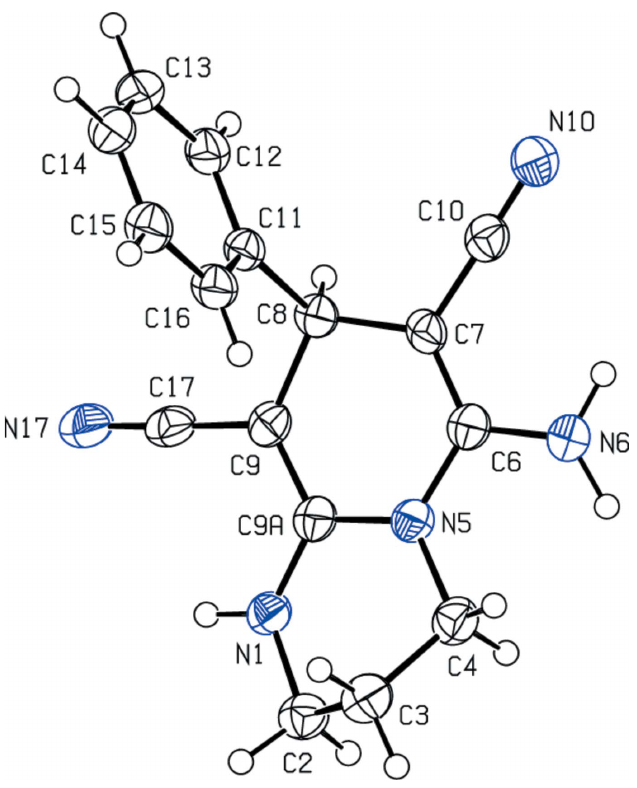
Figure 3 View down [100] showing the formation of (001) layers in the title compound by means of N—H (cid:2)(cid:2)(cid:2) N, C—H (cid:2)(cid:2)(cid:2) N, C—H (cid:2)(cid:2)(cid:2) (cid:2) and N—H (cid:2)(cid:2)(cid:2) (cid:2)